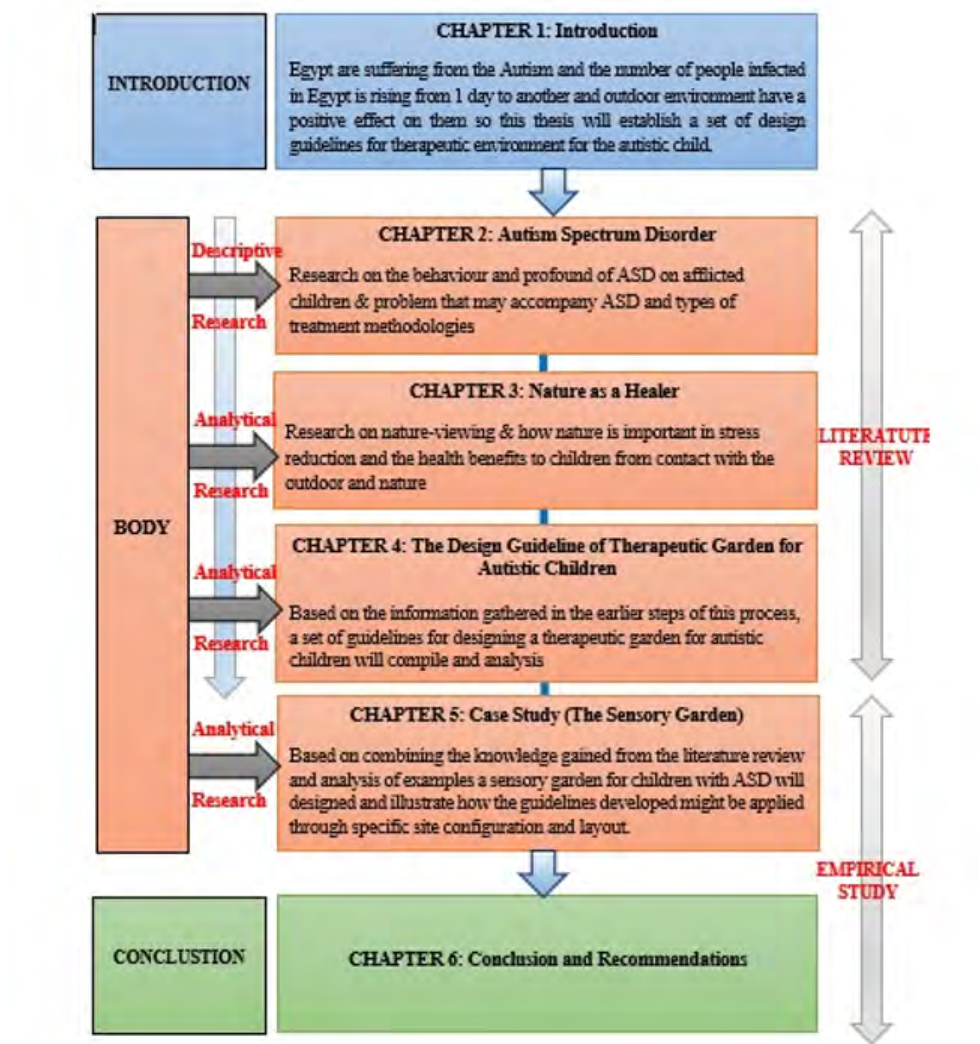
Figure 1. Paper structure diagram